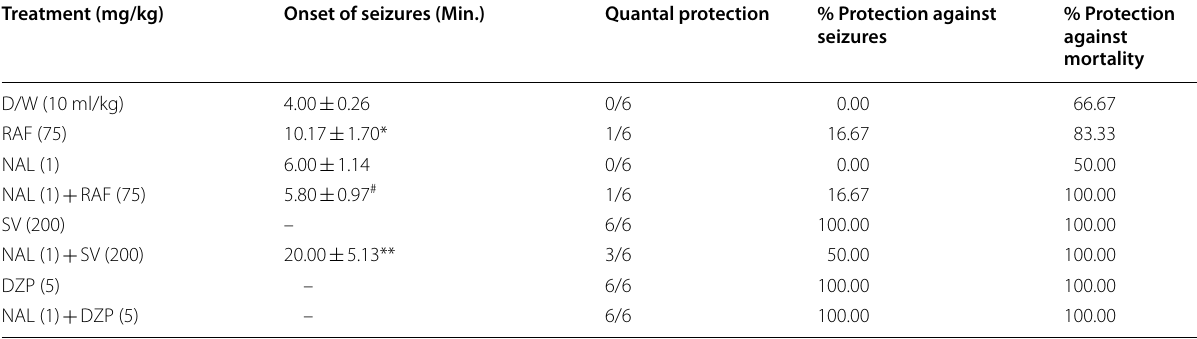
Table 3 Effects of naloxone on RAF of ethanol leaf extract of Ipomoea asarifolia on PTZ-induced seizure in mice Treatment (mg/kg) Onset of seizures